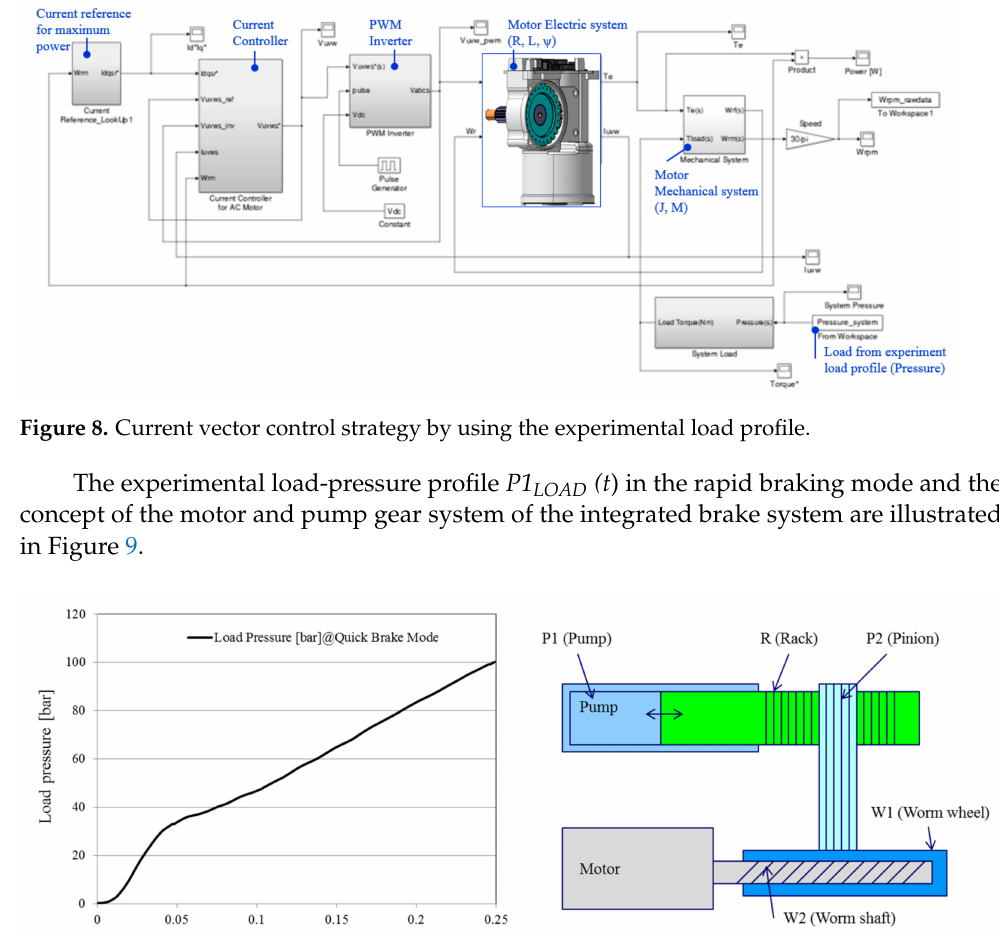
Axial points: 2 × 3 axial points are created by a screening analysis. Cube points: 2 3 cube points are obtained from a full factorial design. Center point: A single point in the center is created by a nominal